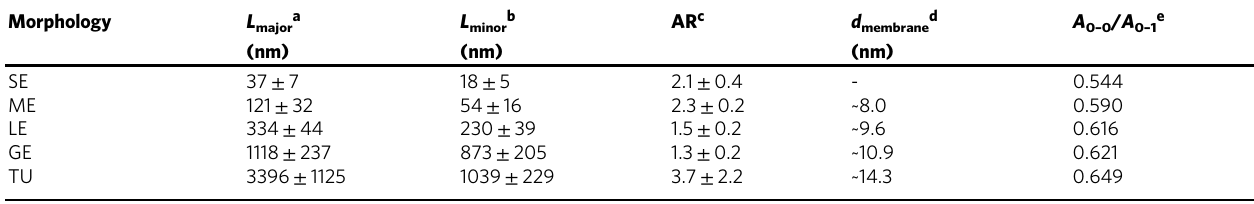
Table 1 Measured geometric parameters and A 0 – 0 / A 0 – 1 values for all fi ve morphologies observed